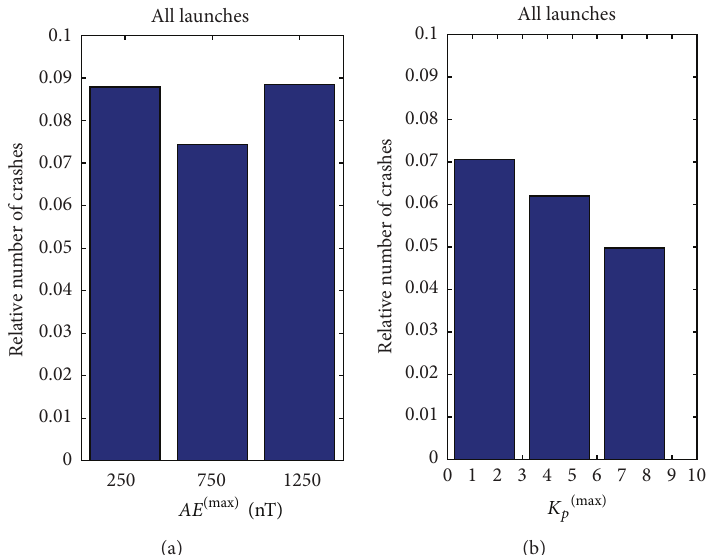
Figure 9: Relative number of crashes for different levels of geomagnetic indices (for maximum value for the previous day) of 𝐾 𝑝 (a) and 𝐴𝐸 (b).